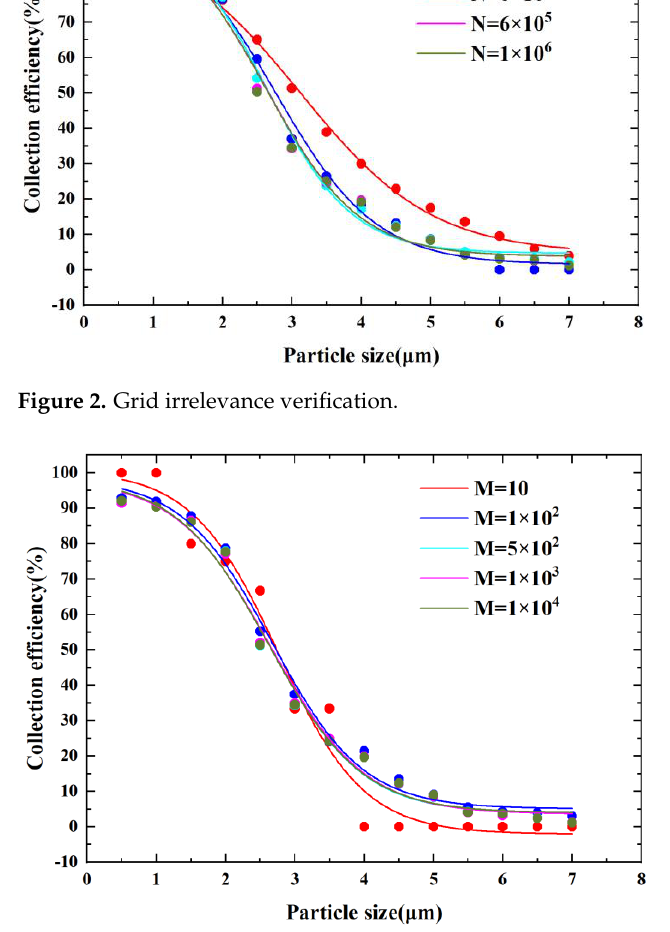
Figure 3. Particle number independence verification.